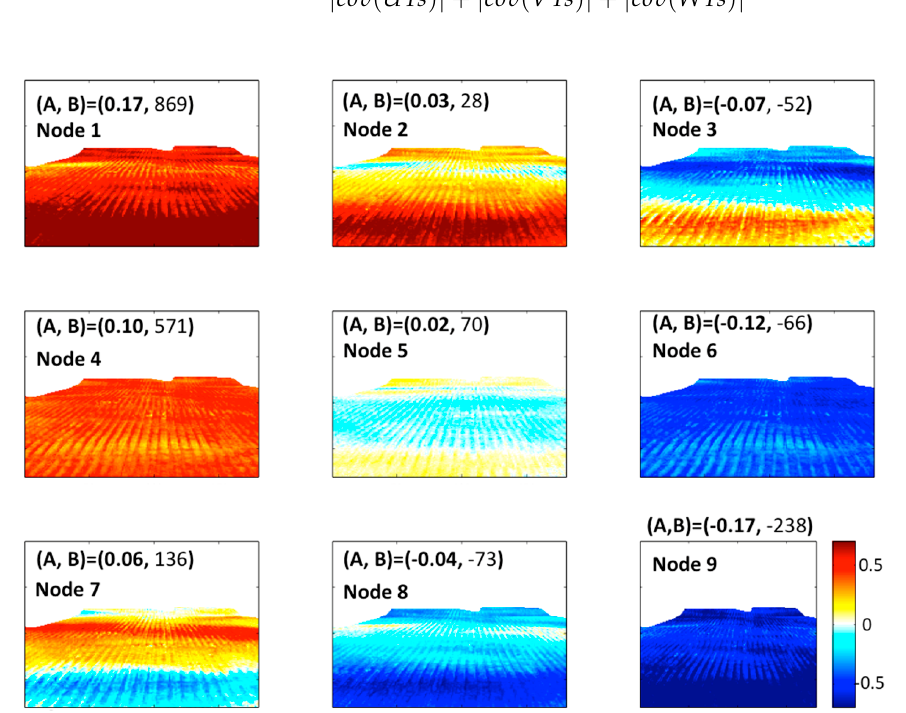
Figure 5. SOM nodes derived from the perturbation brightness temperature. Positive or red values or colors indicate an increase in Tir and negative or blue values or colors indicate a decrease in Tir or surface cooling. The numbers (A, B) on the top of each node are derived from the best matching units of that specific node and are perturbations of (A = average sky brightness perturbation temperature, B = average of the ratio of A by the absolute sum of the three kinematic turbulent heat flux components that were used in Figure 4a).